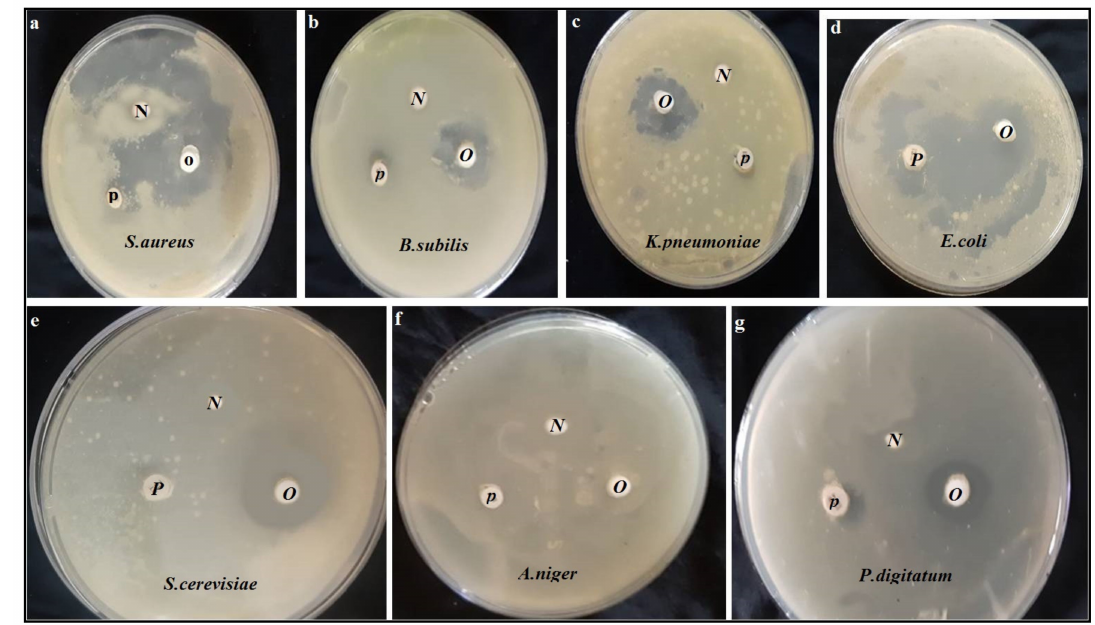
Figure 2. The antimicrobial potency of the OFI oil against tested microbial strains. OFI oil ( O ), negative control ( N ), positive control ( P ).